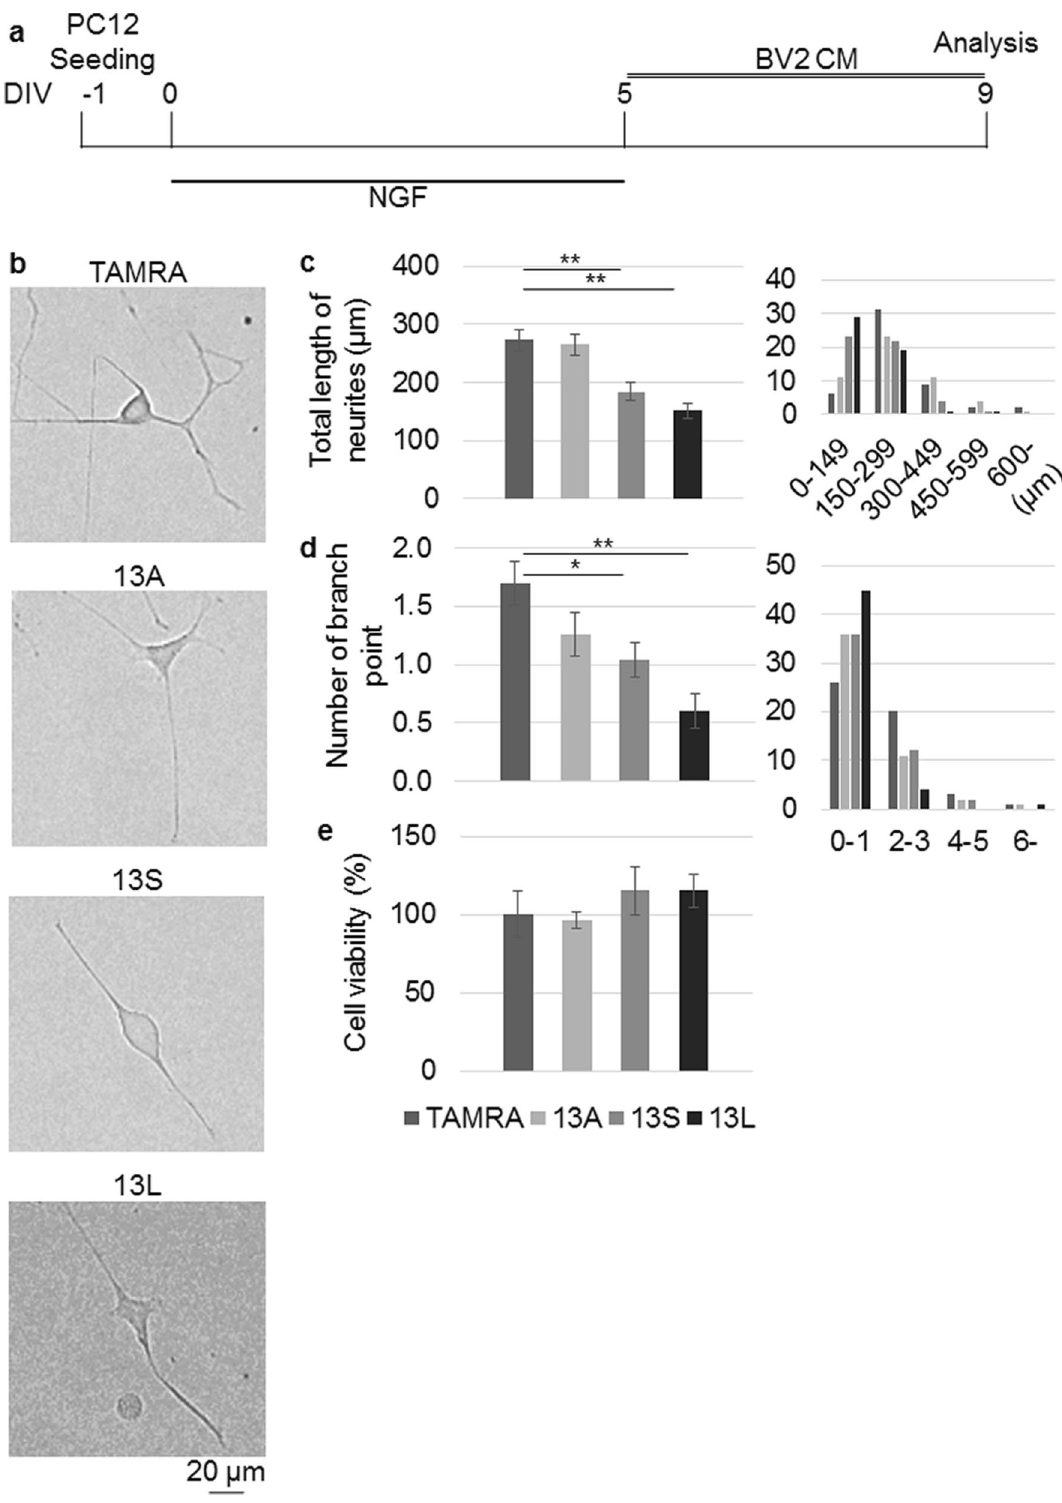
Figure 4. CM derived from BV2 microglia treated with 13S and 13L induce degeneration of differentiated PC12 cells. ( a ) Timing of addition of CM from BV2 microglia having TAMRA, 13A, 13S or 13L. ( b – d ) Representative images ( b ) and quantification of the total length of neurites ( c ) and the number of branch point ( d ) of differentiated PC12 cells cultured in the CM (n = 50 cells, each from 3 independent experiments). x-axis and y-axis of histograms (right panels) indicate distribution of the values and numbers, respectively. ( e ) Viability of PC12 cells in the presence of CMs from BV2 cells with TAMRA, 13A, 13S or 13L. The values relative to that of TAMRA are expressed. Error bars represent SE. ANOVA, *p < 0.05; **p < 0.01. Scale bar 20